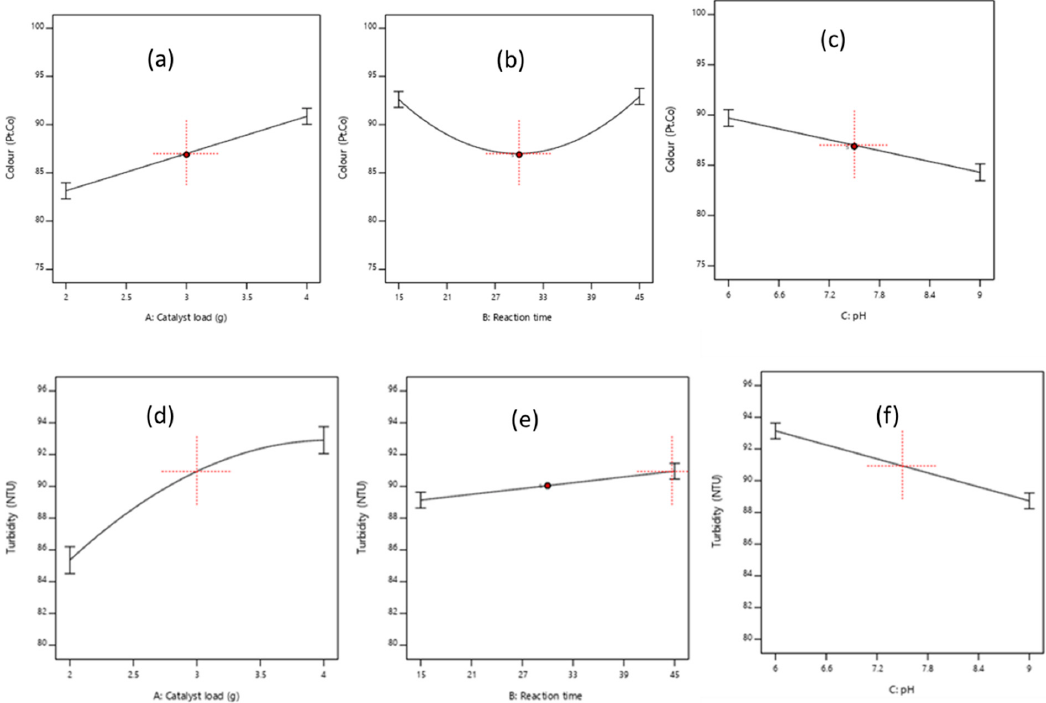
Figure 4. Response representation of individual factors effects on color ( a – c ) and turbidity ( d – f ) removal.